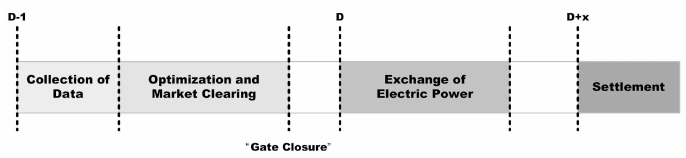
Figure 3. Implementation process of P2P energy trading